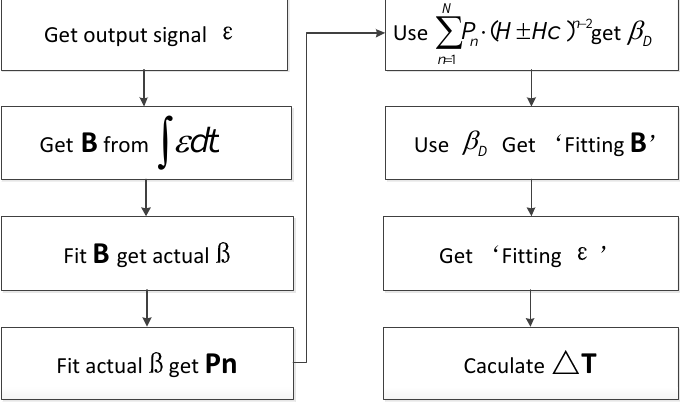
Figure 8. The flow chart of the output response of the RTD-fluxgate by the fitting